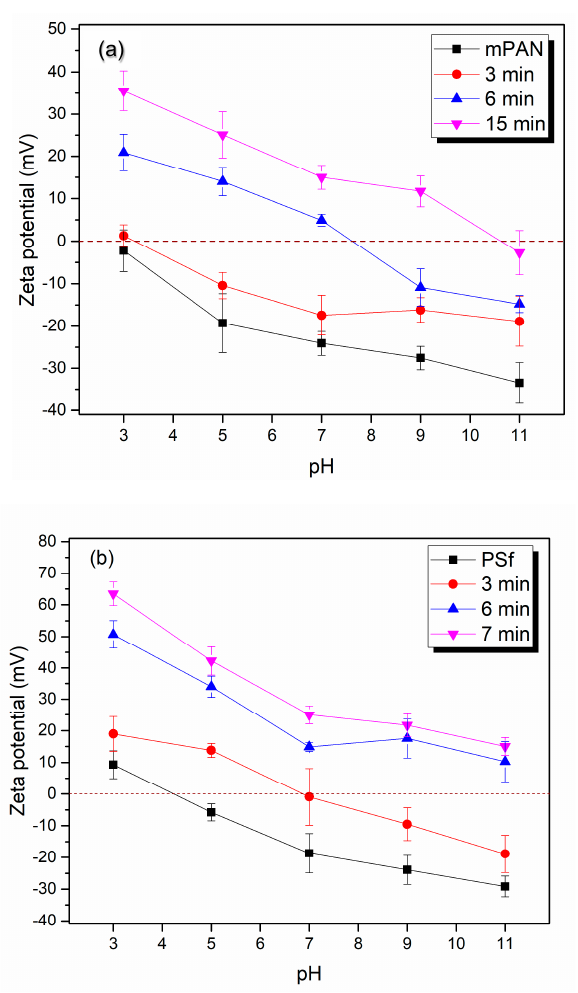
Figure 4. ( a ) Zeta potential of mPAN base membrane, modified mPAN-GMA-DEA membranes with 3, 6, and 15 min UV polymerization, ( b ) Zeta potential of PSf base membrane, modified PSf-GMA-DEA membranes with 3, 6, and 7 min UV polymerization.